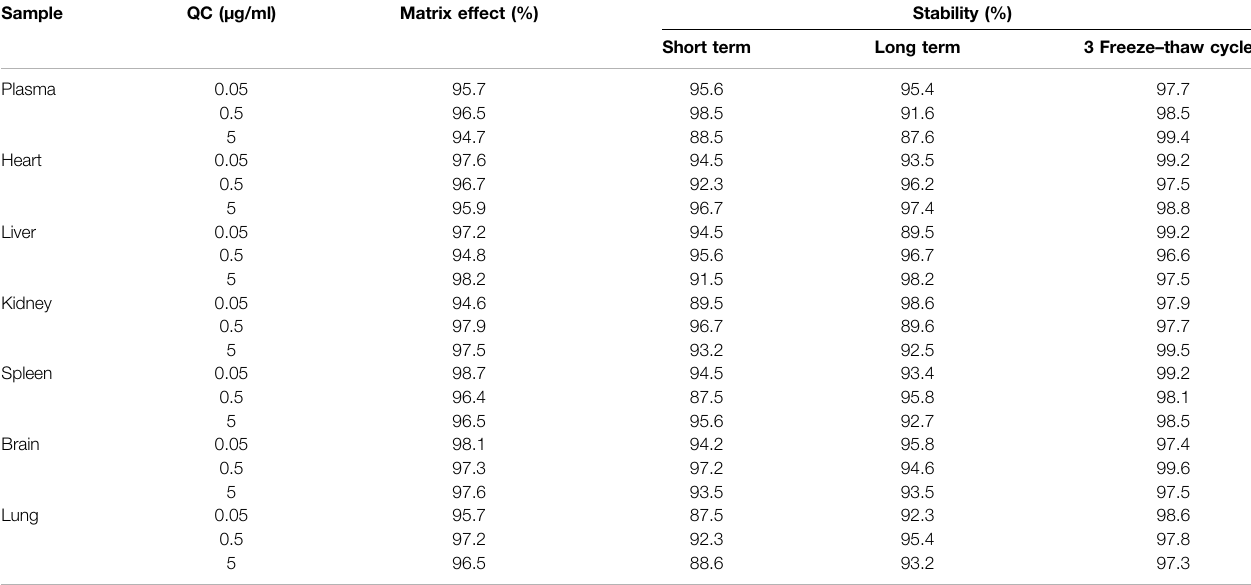
TABLE 2 | Matrix effect and stability of anwulignan in plasma and tissue samples.